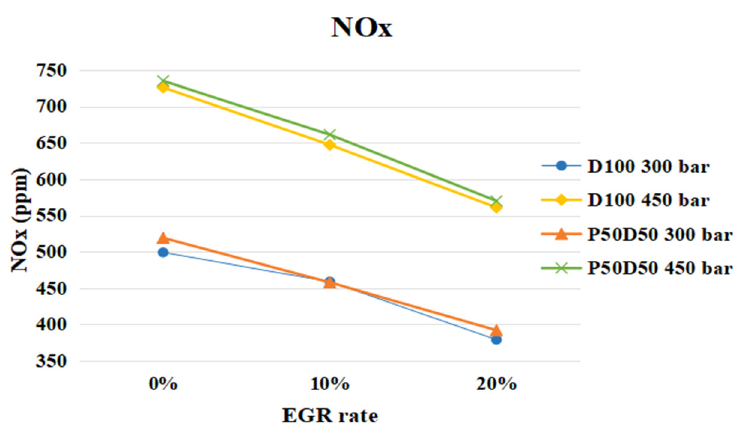
Figure 14. NOx emissions under different EGR rates at 300 and 450 bar.